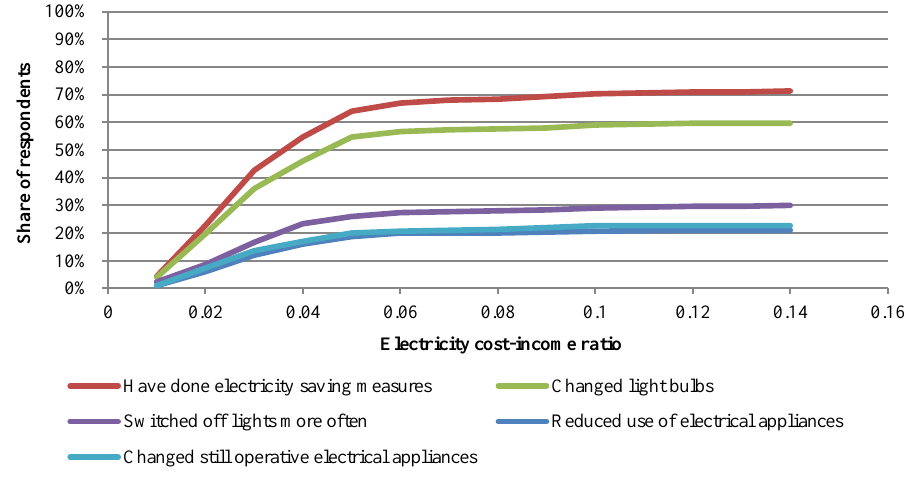
Fig. 7. Relation between the share of respondents and electricity saving measures accomplished during the last three years, and the electricity cost-income ratio within the high-income